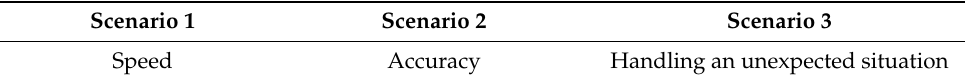
Table 3. Evaluation indices for the three scenarios.